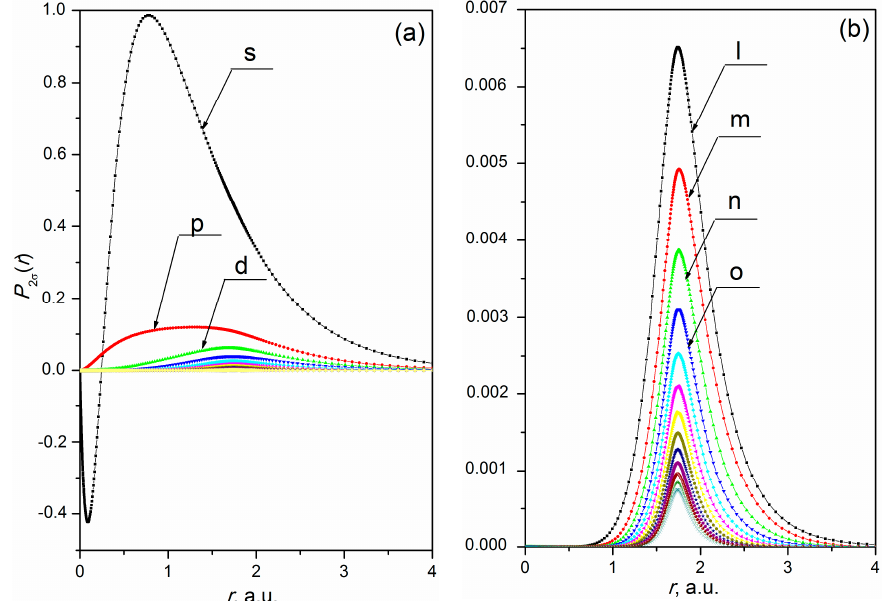
Figure 1. Radial parts of partial harmonics of SC expansion of 2 σ –MO of the ground HF molecule state. Calculation of the ground state is performed for the equilibrium distance ( R 0 = 1.733 a.u. [35]) between the atom nuclei of H and F: ( a ) SC expansion of MO into a series (1) c l ≤ 60; and ( b ) SC expansion of MO into a series (1) c l ≥ 8. Algorithms 2018 , 11 , 1 11 of 14